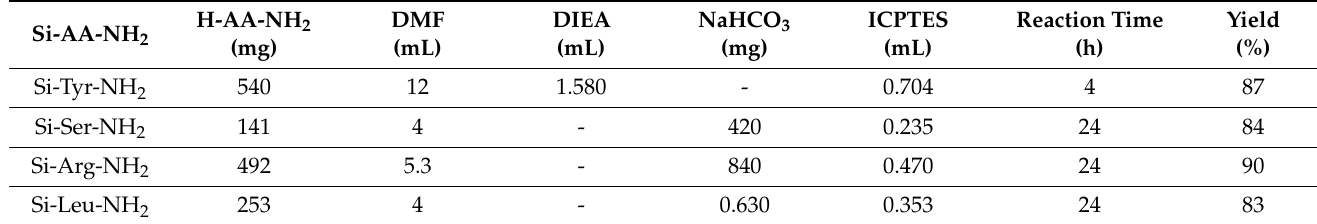
Table 4. Summary of the synthesis conditions of the hybrid amino-acid-based